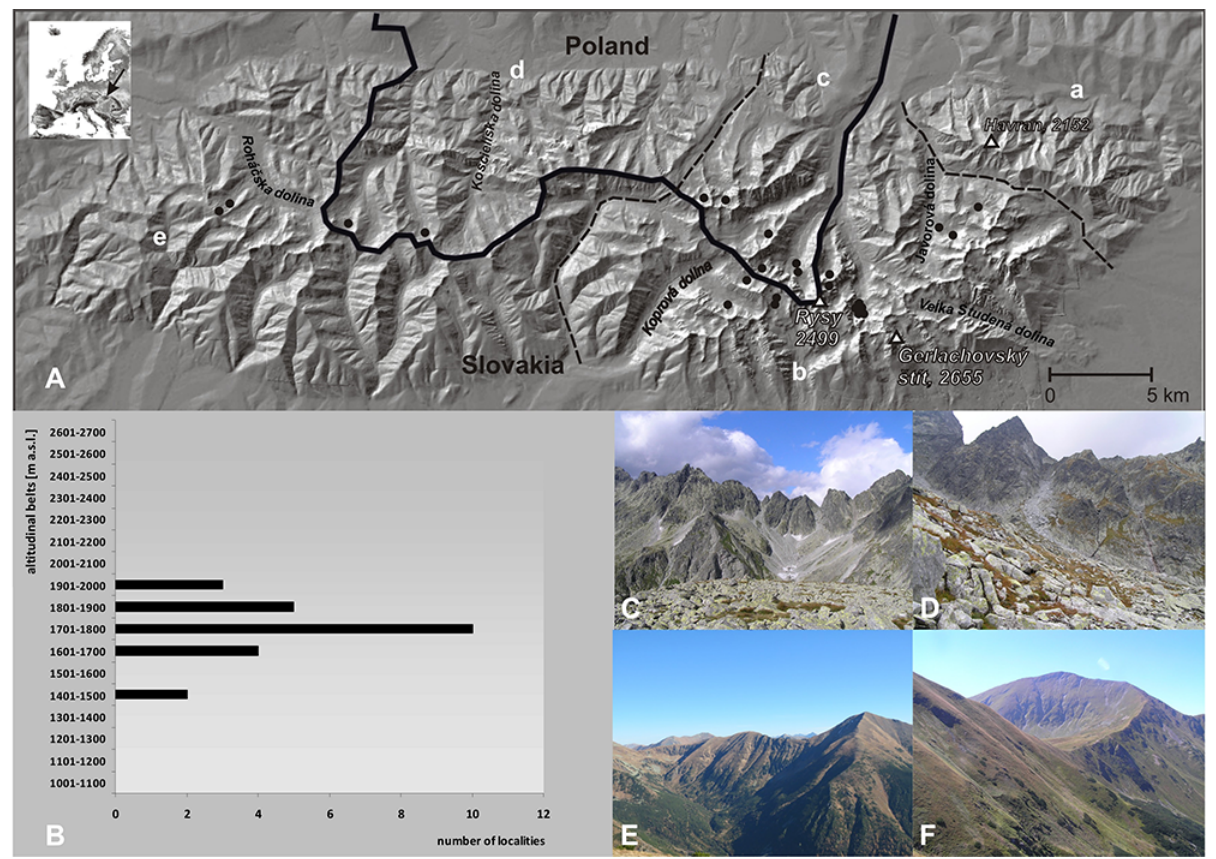
Figure 1 Distribution of Marsupella subemarginata Bakalin & Fedosov in the Tatra Mountains. ( A ) Localities of the liverwort (black dots) and geobotanical division of the massive: a – Belianske Tatra Mts; b, c – High Tatra Mts; d, e – Western Tatra Mts. ( B ) Vertical distribution of M. subemarginata in altitudinal belts: ( C–F ) landscapes of the High Tatra Mts ( C,D ) and Western Tatra Mts ( E,F